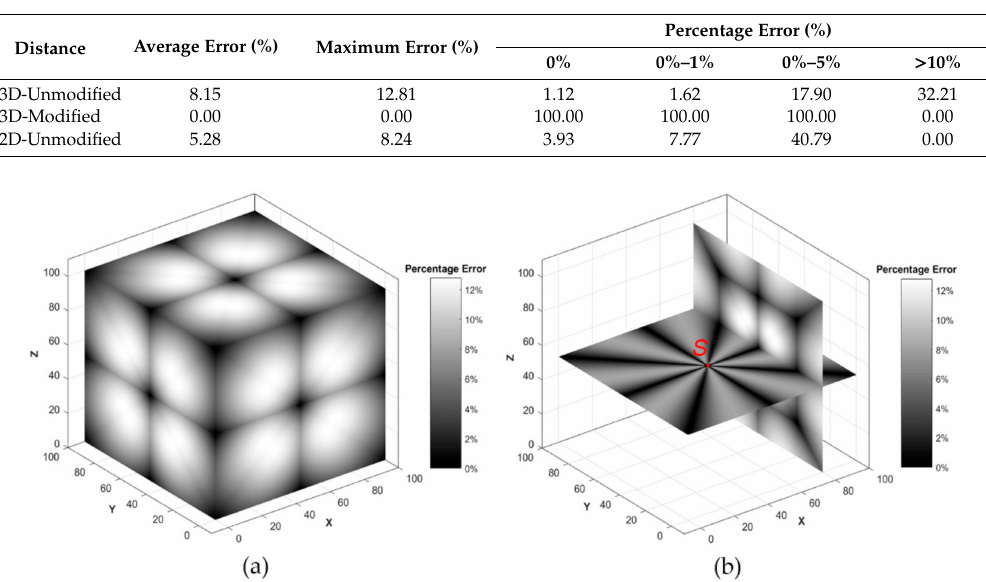
Table 1. Accuracy of the distance calculated by the conventional unmodified method and our algorithm (modified).